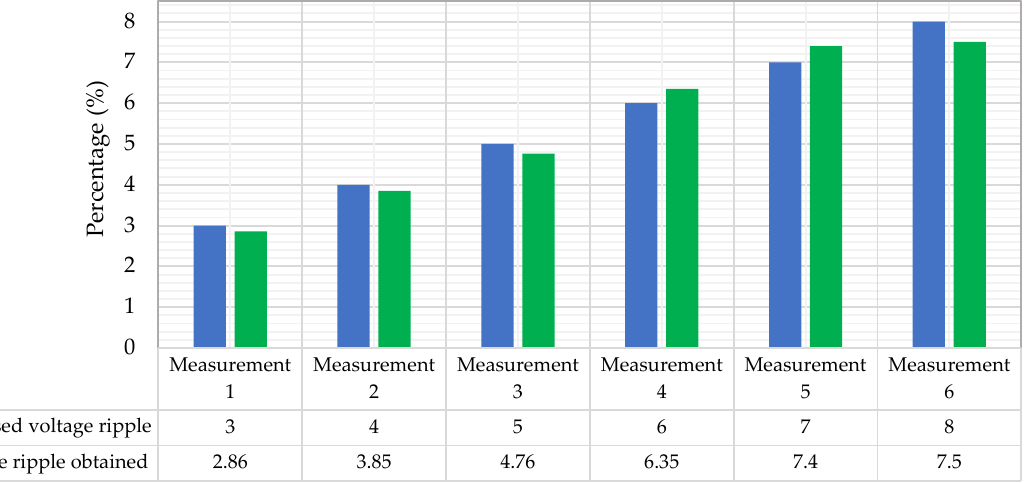
Figure 13. Comparison between proposed voltage ripples and voltage ripples obtained with devel- oped minimum capacitance equation.